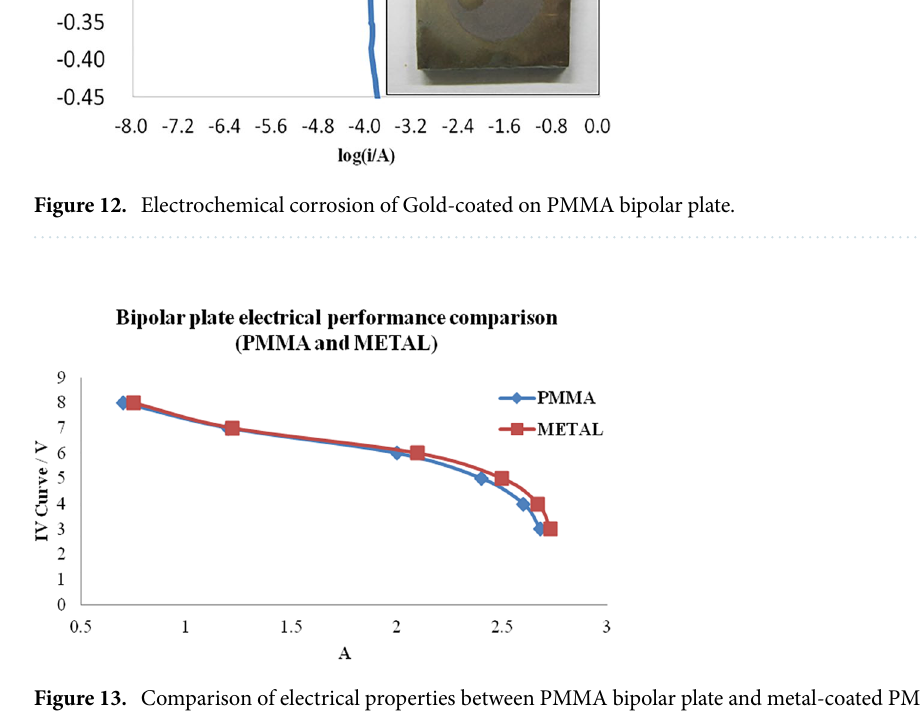
Figure 13. Comparison of electrical properties between PMMA bipolar plate and metal-coated PMMA bipolar